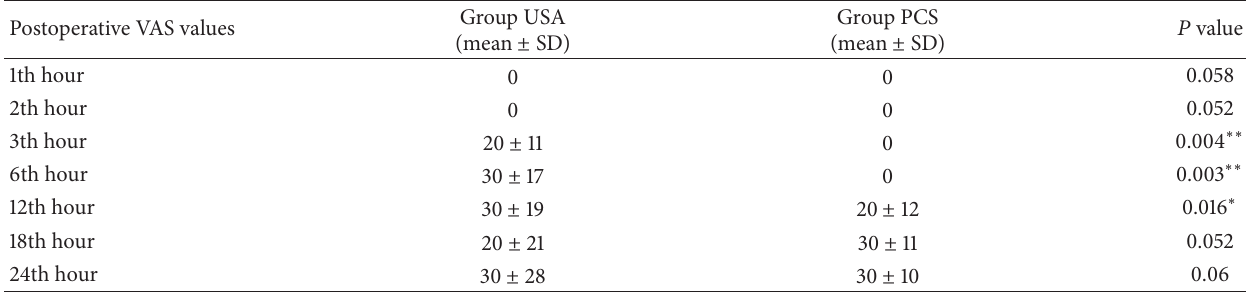
Table 5: Postoperative VAS (visual analogue scale) values (mm) (mean ± SD). In between-groups comparisons; ∗∗ 𝑝 < 0.01; ∗ 𝑝 < 0.05 . Postoperative VAS